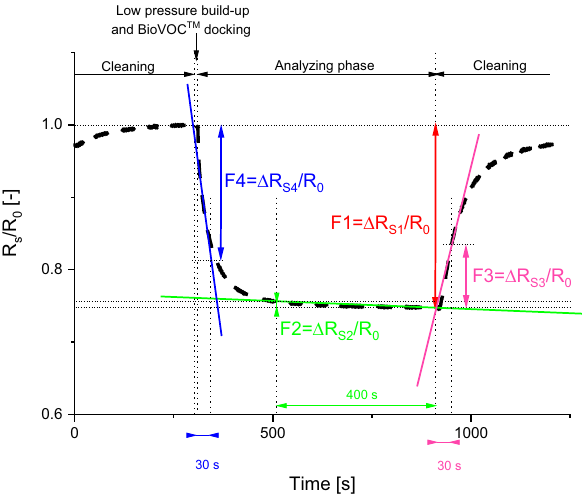
Figure 2. Illustration of the recorded relative changes of gas sensor DC resistance R S during breath sample analysis, related to its initial resistance R 0 after sensor cleaning. The four parameters of DC resistance